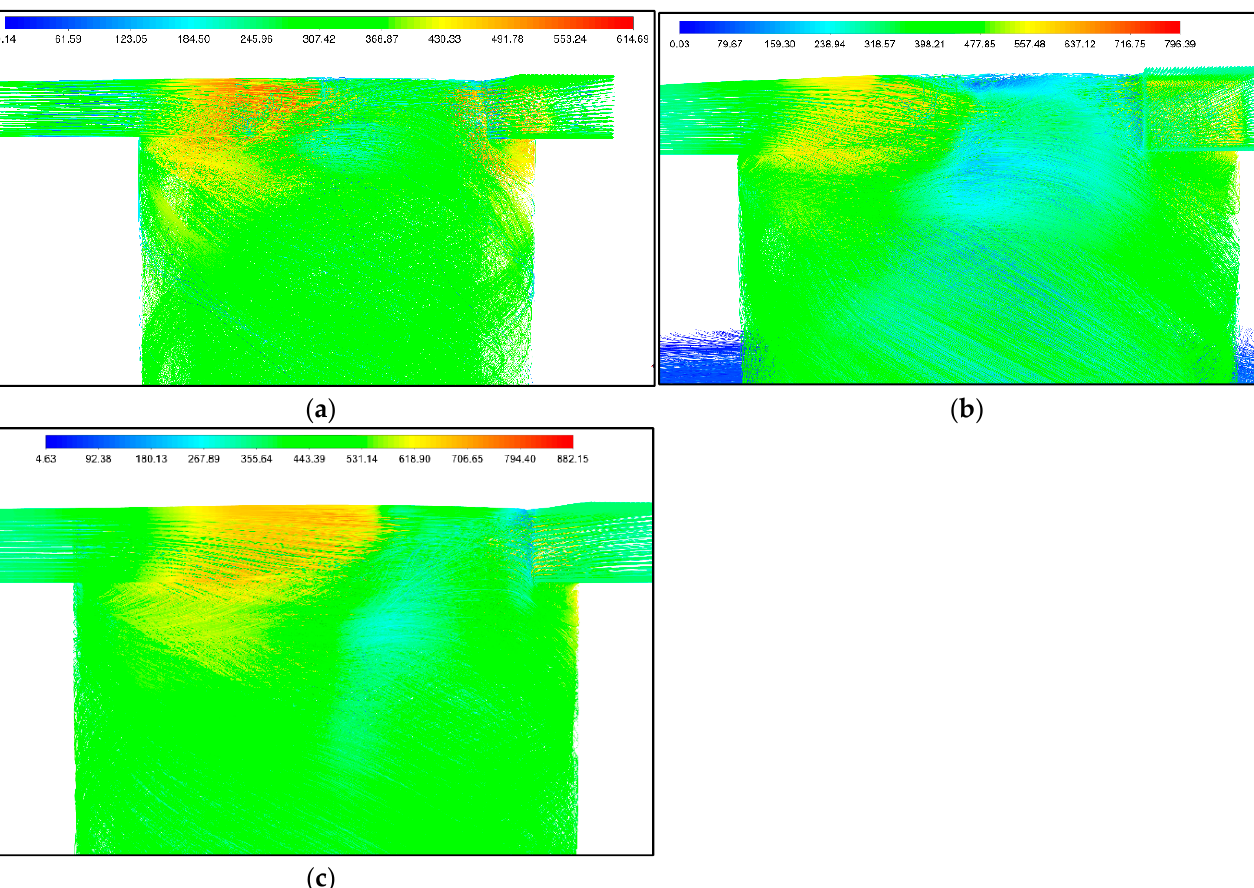
Figure 4. Velocity streamlines obtained for SVT with ( a ) inviscid Ar ; ( b ) inviscid CO 2 ; and ( c ) inviscid air . The total temperature contour drawn along the nozzles shows that the absence of gas viscosity leads to SVT with no cooling efficiency (Figure 5).